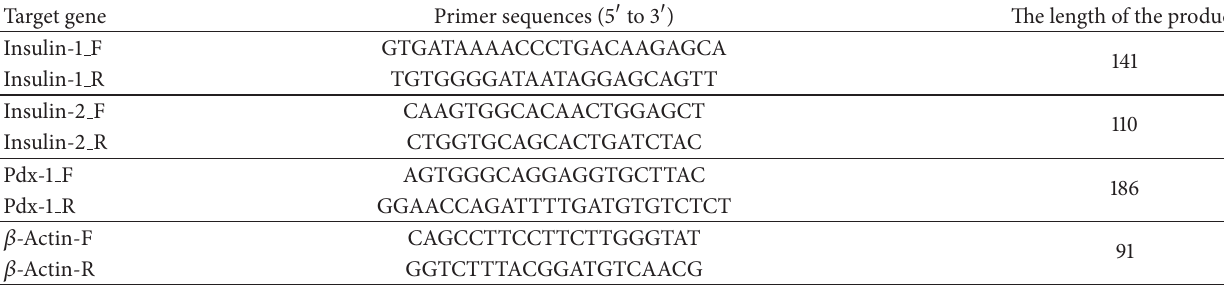
Table 4: mRNA primer design for INS-1, INS-2, and PDX-1 in pancreas.